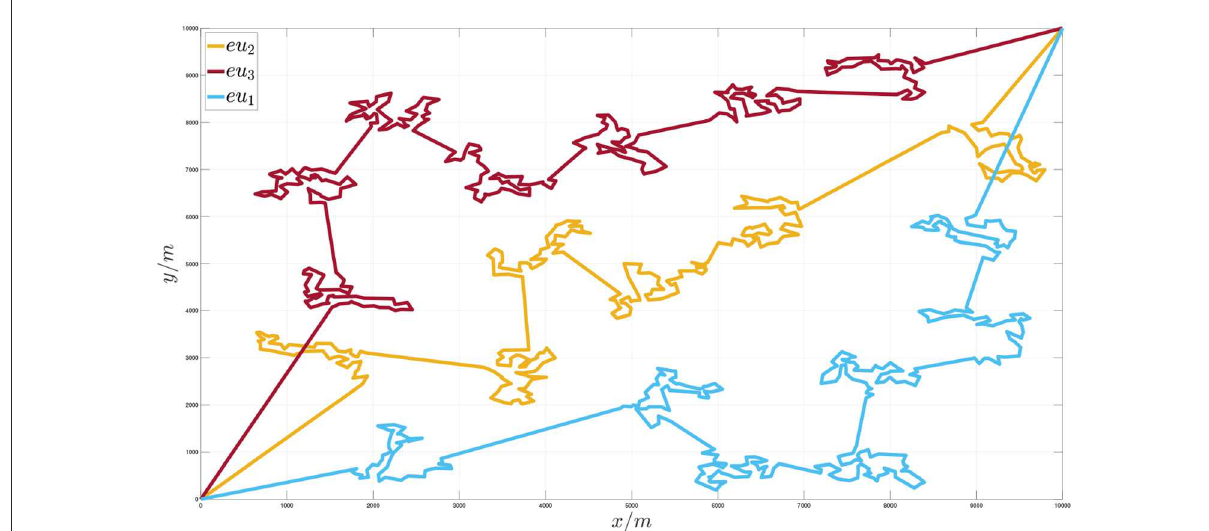
FIGURE7 Schematic diagram of the execution unit accessing node sequence when the number of target task nodes is 1,000.